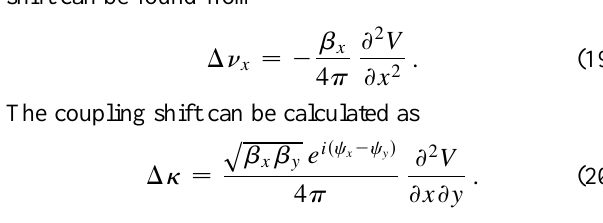
FIG. 5. (Color) Contour plots of the original electron density (top left), (cid:197) (cid:112) density (top right), change of the electron density due to interaction with (cid:197) (cid:112) space charge (bottom left), and the resulting electron density. shift can be found